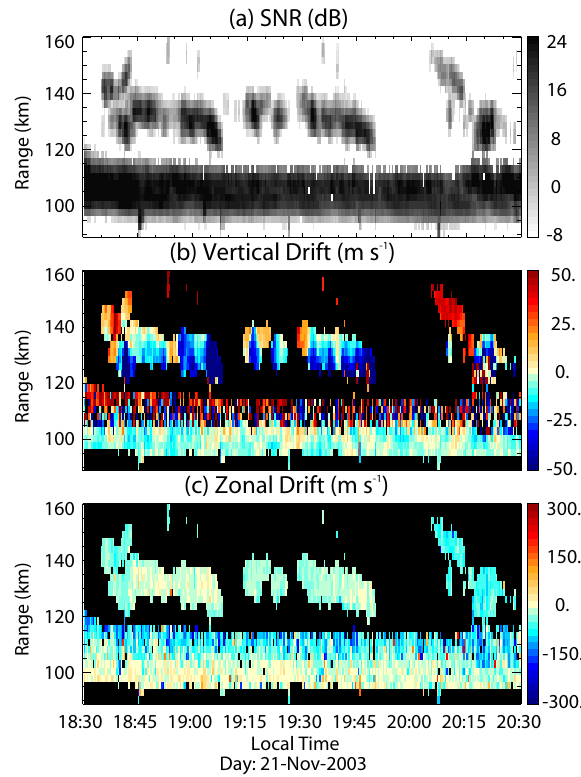
Fig. 1. JULIA EEJ observations around twilight on 21 November 2003. (a) Range-time intensity, (b) Doppler velocity, and (c) zonal drift. Note the occurrence of echoes above 120kms.